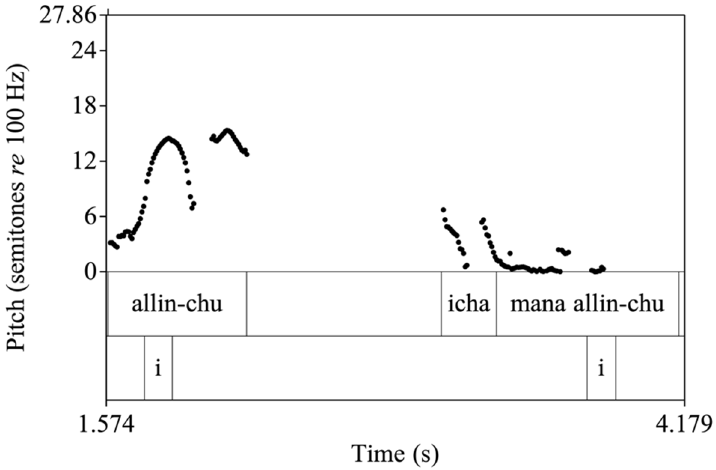
Figure 1. Final falling contour in a yes/no question “Good or not good?” as produced by a male Quechua–Spanish bilingual.